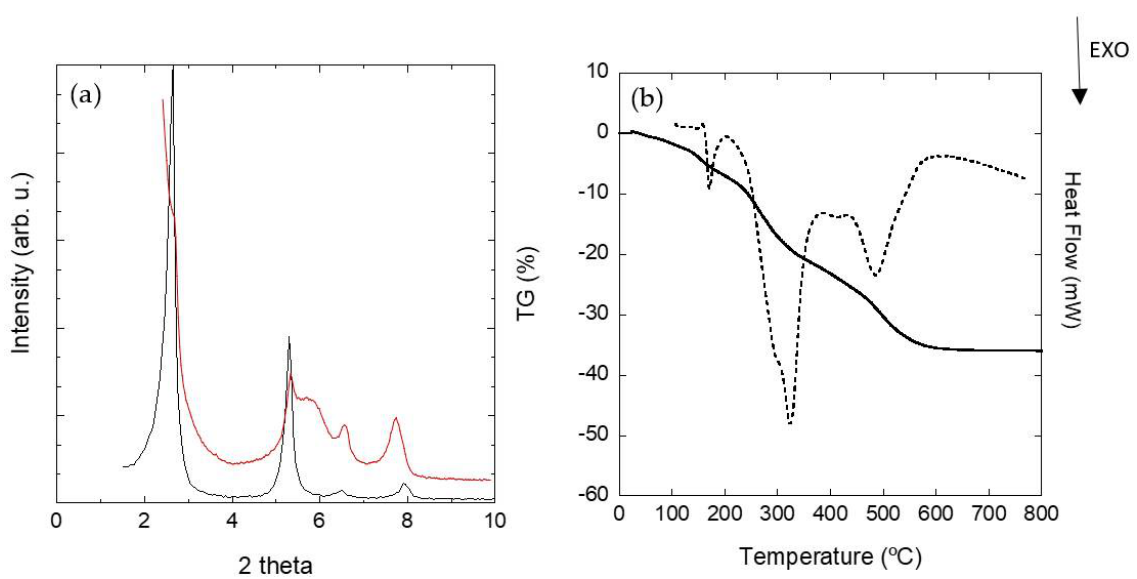
Figure 7. XRD patterns of the amphiphilic mica, C 16 H 33 NH(CH 3 ) 2+ -mica, before (black) and after the Eu(NO 3 ) 3 treatment (red) ( a ); TG (solid line) and DSC (dashed line) plots for on C 16 H 33 NH(CH 3 ) 2+ -mica after Eu 3+ cation adsorption ( b ).